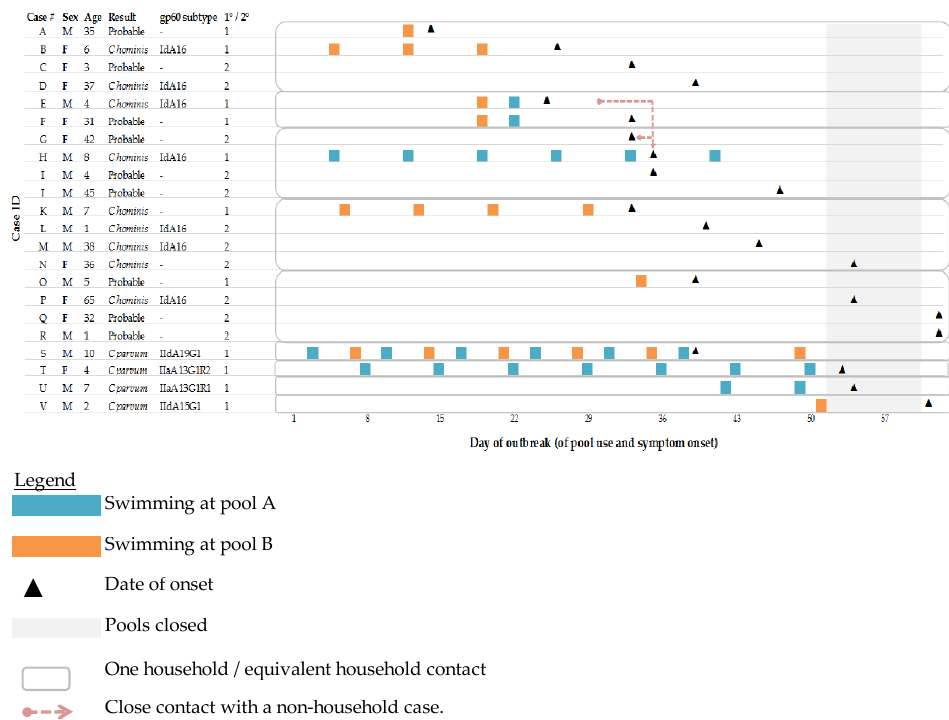
Figure 2. Cryptosporidium outbreak timeline of laboratory results, dates of swimming, symptom onset, and pool closures, for primary (1°) and secondary (2°) cases, North East of England, 2016 (n = 22)